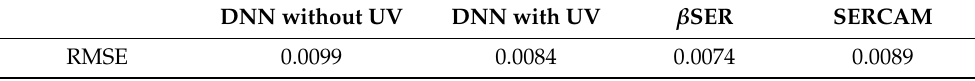
Figure 12. The prediction results of different models under different input conditions. ( a ) the prediction results of DNN without UV; ( b ) the prediction results of DNN with UV; ( c ) the prediction results of β SER; ( d ) the prediction results of SERCAM. Table 3. RMSE of the